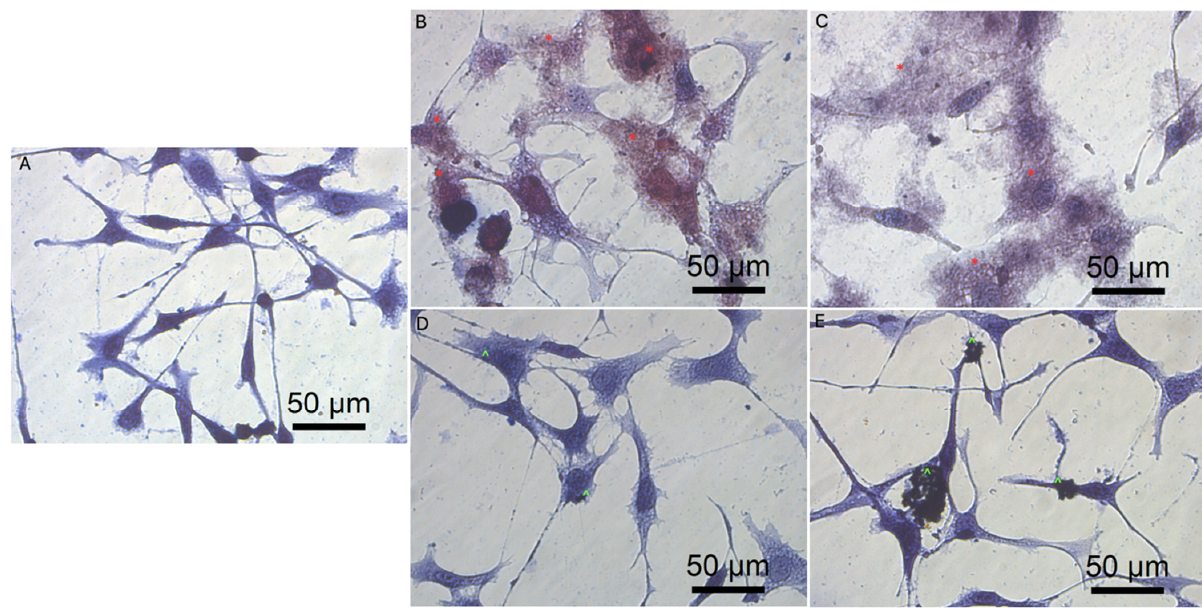
Figure 6. Morphology of U118 glioblastoma cells. ( A ) untreated cells (control group), cells treated with graphene oxide at concentration: 5µg/mL ( B ), 100µg/mL ( C ), and reduced graphene oxide at concentration: 5 µg/mL ( D ) and 100 µg/mL ( E ). Red * GO at cell membrane. Green ^ rGO at cell membrane. Light optical microscopy. Scale bars: 50 µm. ( A – E ). Abbreviations: GO: graphene oxide, rGO: reduced graphene oxide.